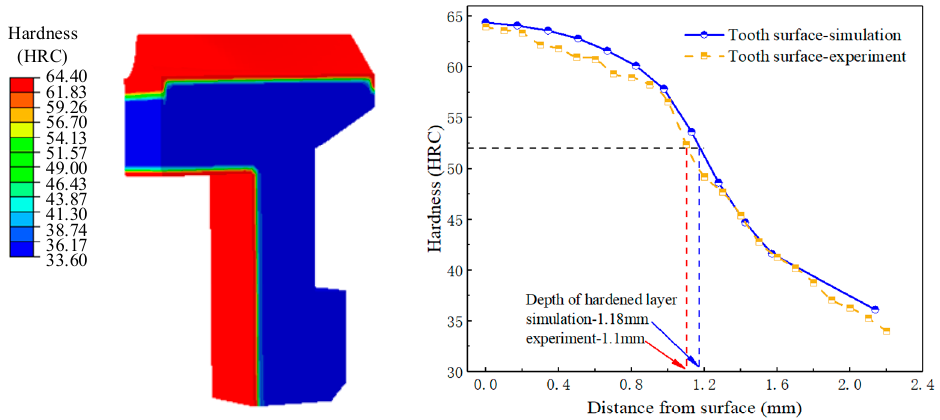
Figure 19. Comparison between simulation and experimental values of tooth surface hardness distribution.